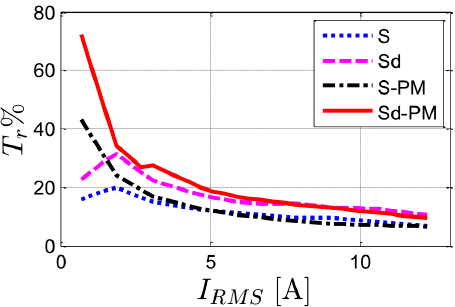
Figure 14. SynRM torque ripple % ( T r ) as a function of stator current ( RMS ) at optimal current angles and rated speed.